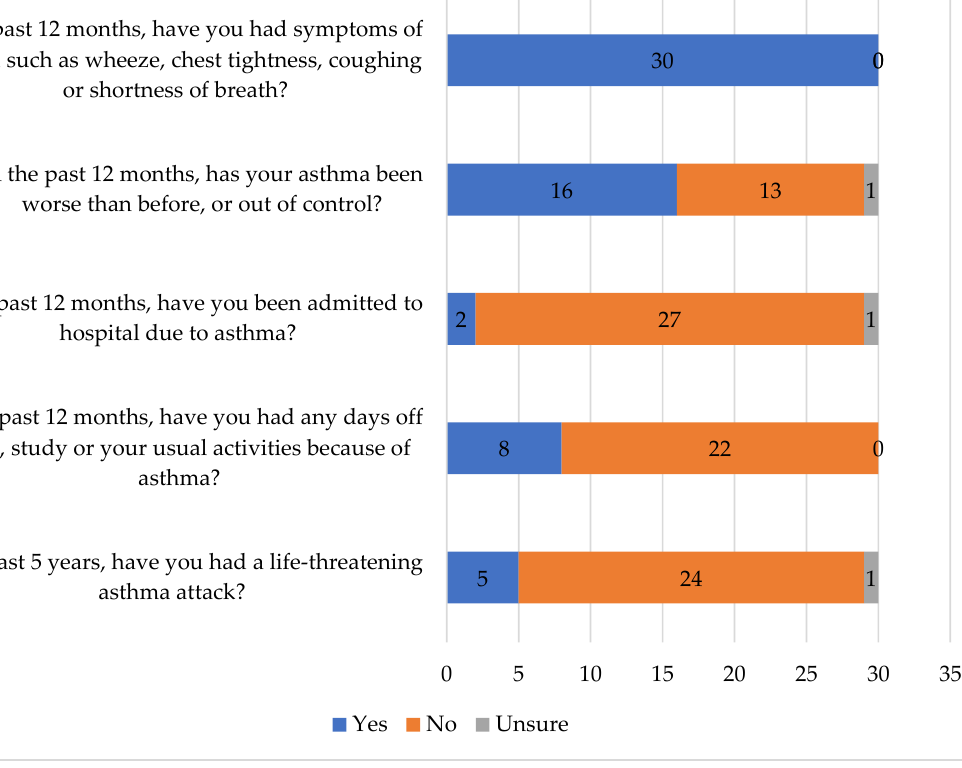
Figure 2. Respondents’ agreement with statements related to asthma. Only eight (26.7%) respondents with asthma had an Asthma Action Plan and three had referred to it in the past 12 months to manage their asthma. Most (7/8; 87.5%) felt confident to use their Asthma Action Plan.